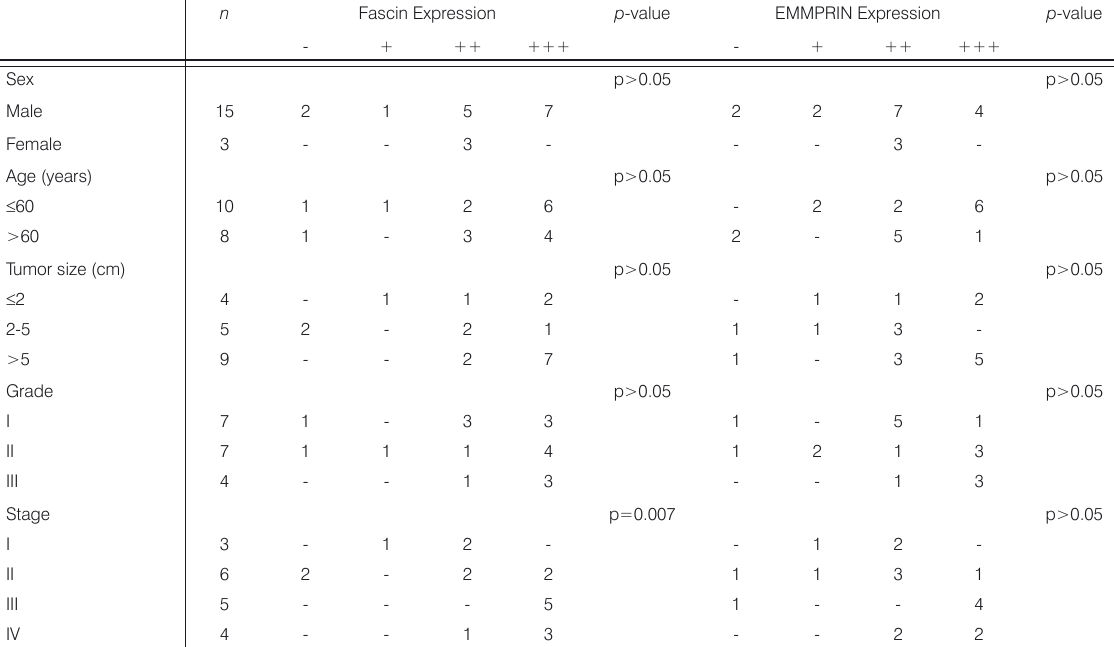
Table 2. Fascin and EMMPRIN expression levels and relationships with clinicopathological features in adenocarcinomas.